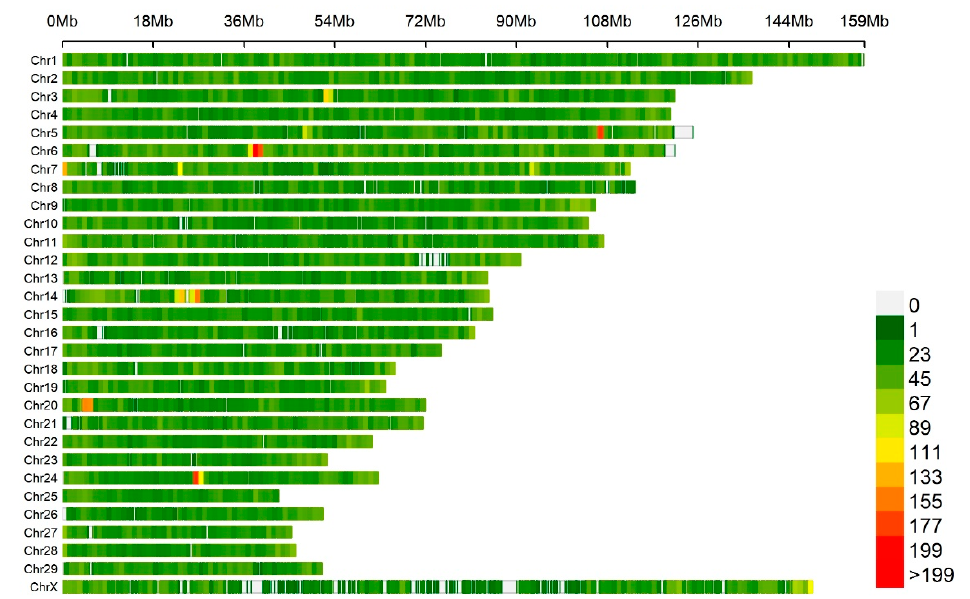
Figure 2. The SNPs’ density distribution on 29 autosomes and the X-chromosome of the bovine genome. The horizontal axis ( X -axis) shows the chromosome length (Mbp). SNP density was calculated per 1 Mbp window. Different colors represent different SNP density levels.